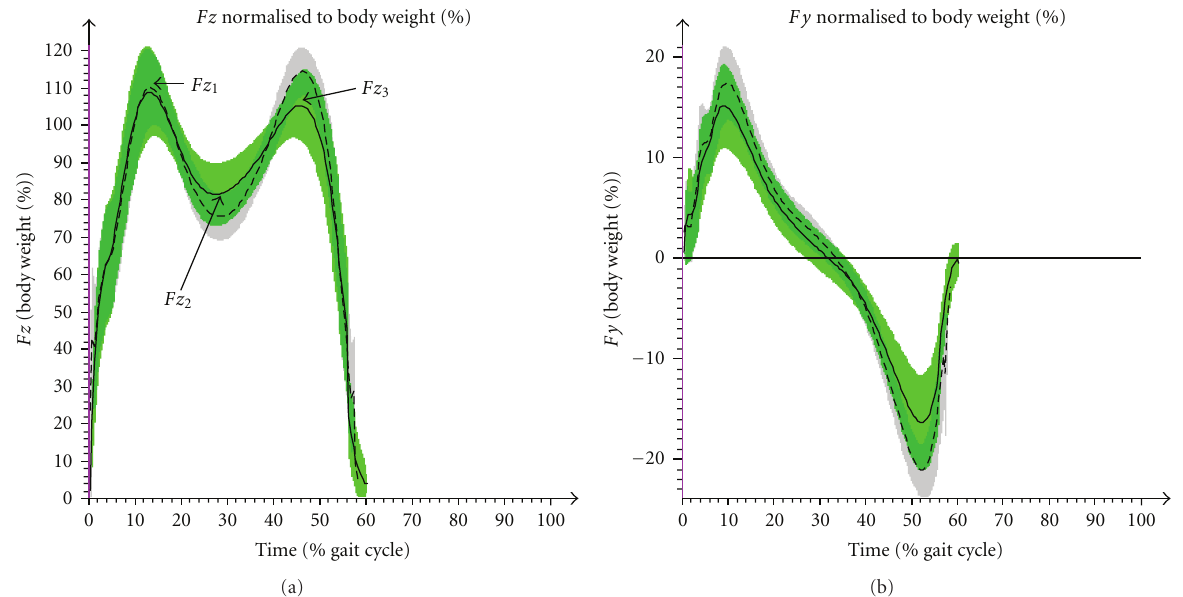
Figure 7: Kinetic results of CG (arithmetic mean & SD (---)) and JIA-P (arithmetic mean & SD (—)) in time normalized (%) gait cycle of ground reaction forces (GRF). (a) In the vertical GRF ( Fz ) the peaks Fz 1 , Fz 3 and the value Fz 2 were compared. (b) In the horizontal GRF ( Fy ) in gait direction the max. peak and the min. peak were used for statistical